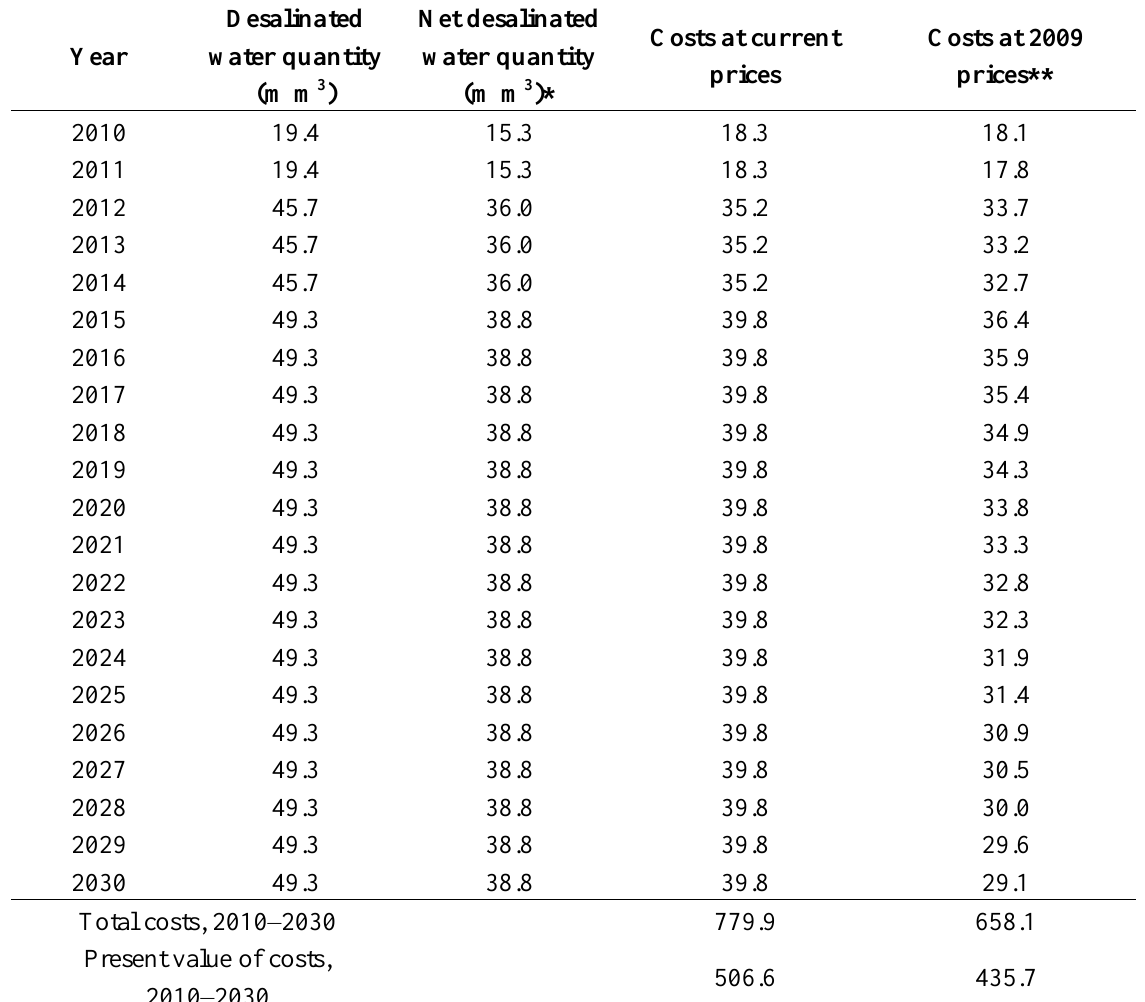
Table 5. Future annual desalination costs for the government of Cyprus (million Euros) due to desalination plants starting operation after